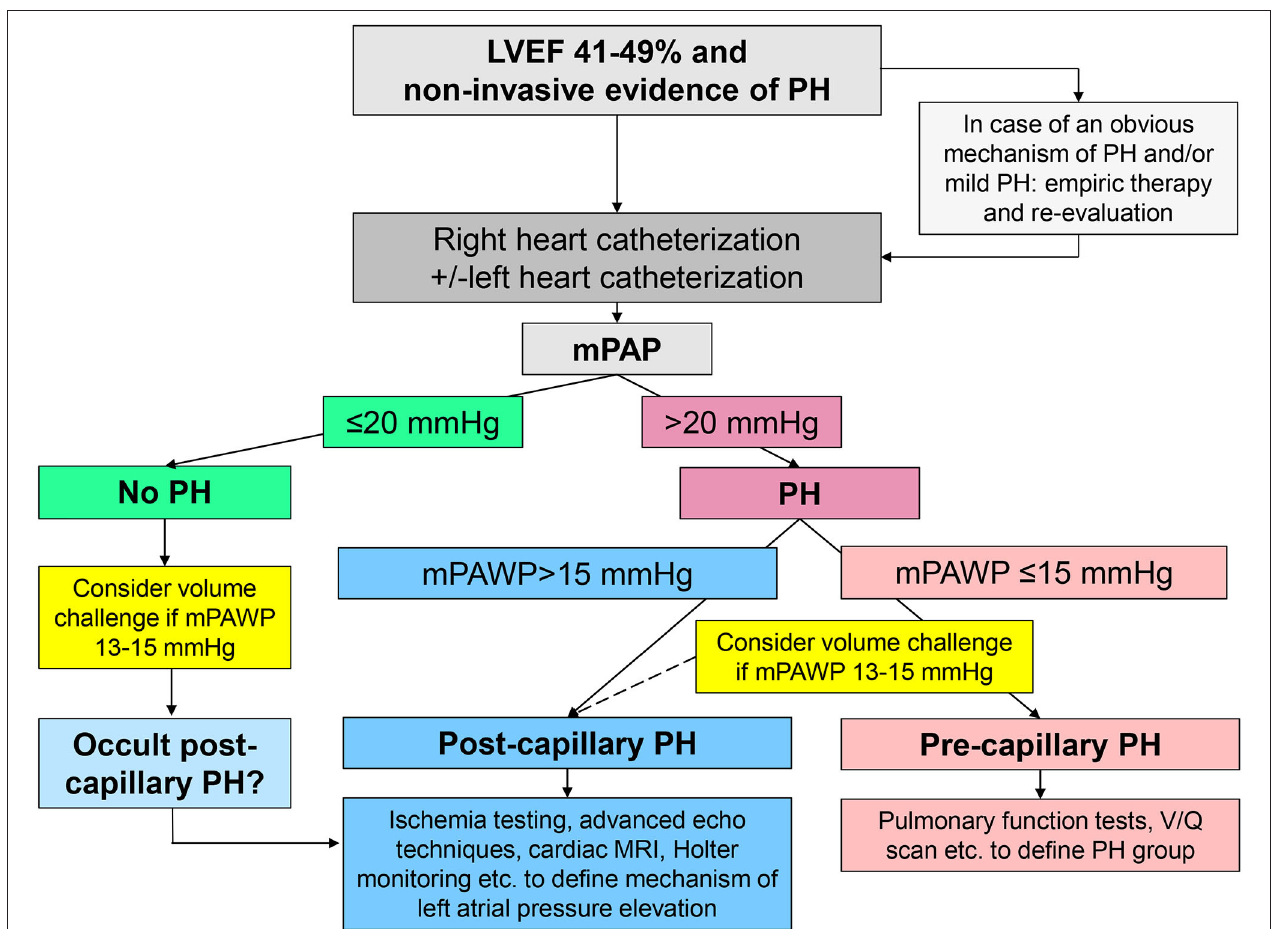
FIGURE 3 | Schematic representation of the non-invasive and invasive work-up in patients with mid-range left ventricular ejection fraction (LVEF) of 41–49% and evidence of pulmonary hypertension (PH). mPAP, mean pulmonary artery pressure; mPAWP, mean pulmonary artery wedge pressure; MRI, magnetic resonance imaging; V/Q scan, ventilation perfusion